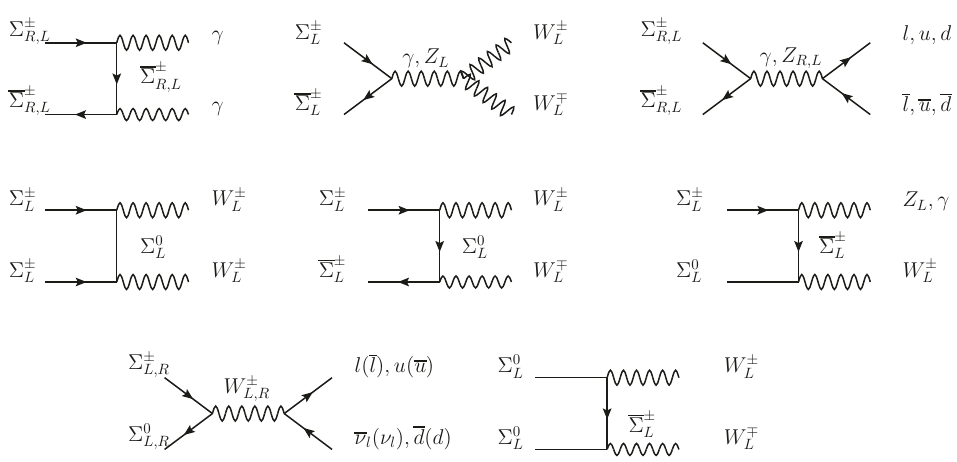
Figure 2 . The annihilation and coannihilation diagrams for fermion triplet dark matter relevant for relic density computation within the framework of minimal left-right dark matter